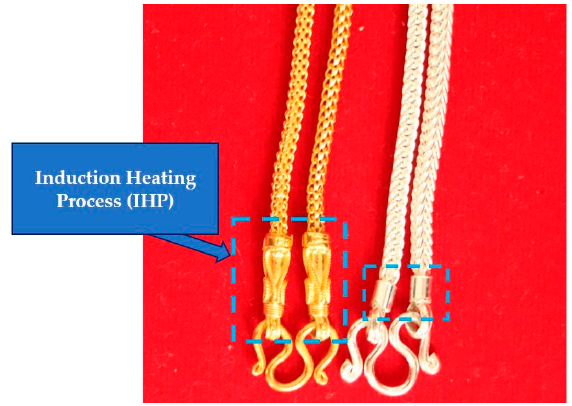
Figure 1. Gold and silver necklaces manufactured from the IHP of a jewelry factory.